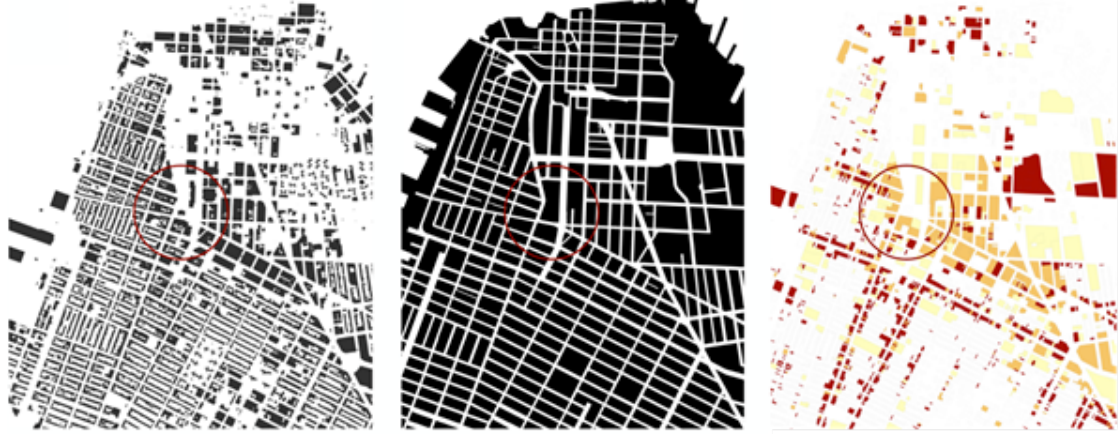
Figure 11. Left: figure ground diagram of buildings to open space; centre: blocks to streets; right: use pattern diagram (Source: author)